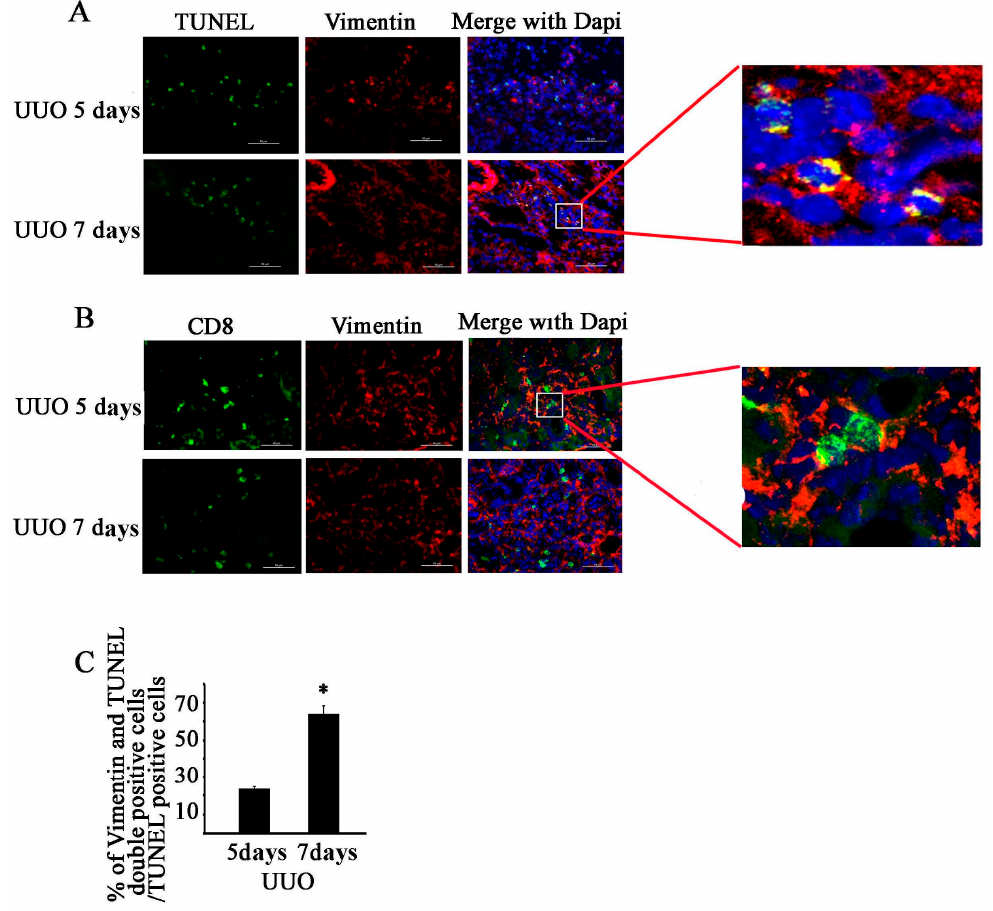
Figure 4. CD8 + T cells are associated with apoptosis of fibroblast in obstructed kidney. ( A ) Double immunostaining in kidney was performed using anti-vimentin (red) and TUNEL (green) at UUO 5 or 7 days (bar = 50 µ m); ( B ) Double immunostaining in kidney was performed using anti-vimentin (red) and anti-CD8 (green) at UUO 5 or 7 days (Bar = 50 µ m); ( C ) Percentage of vimentin- and TUNEL-double positive cells among TUNEL-positive cells was calculated (* p < 0.05; n = 5).